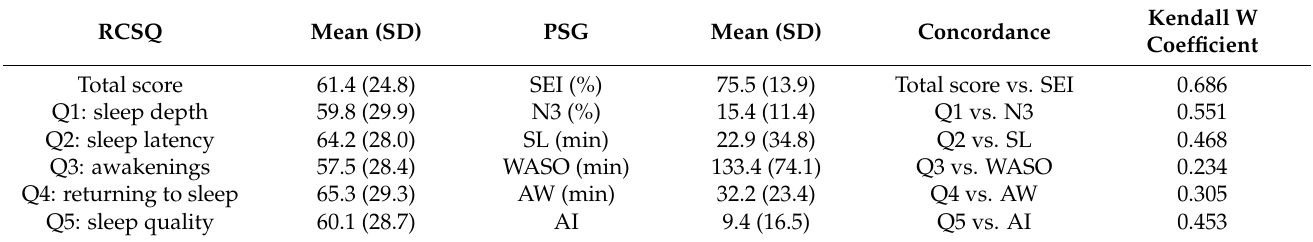
Table 3. Concordance between RCSQ total scores and RCSQ single items with the corresponding PSG parameters. SEI, sleep efficiency index; N3, duration of N3 stage on the sleep period time; SL, sleep latency; WASO, wake after sleep onset; AW, mean duration of awakenings lasting more than two minutes; AI, arousal index.